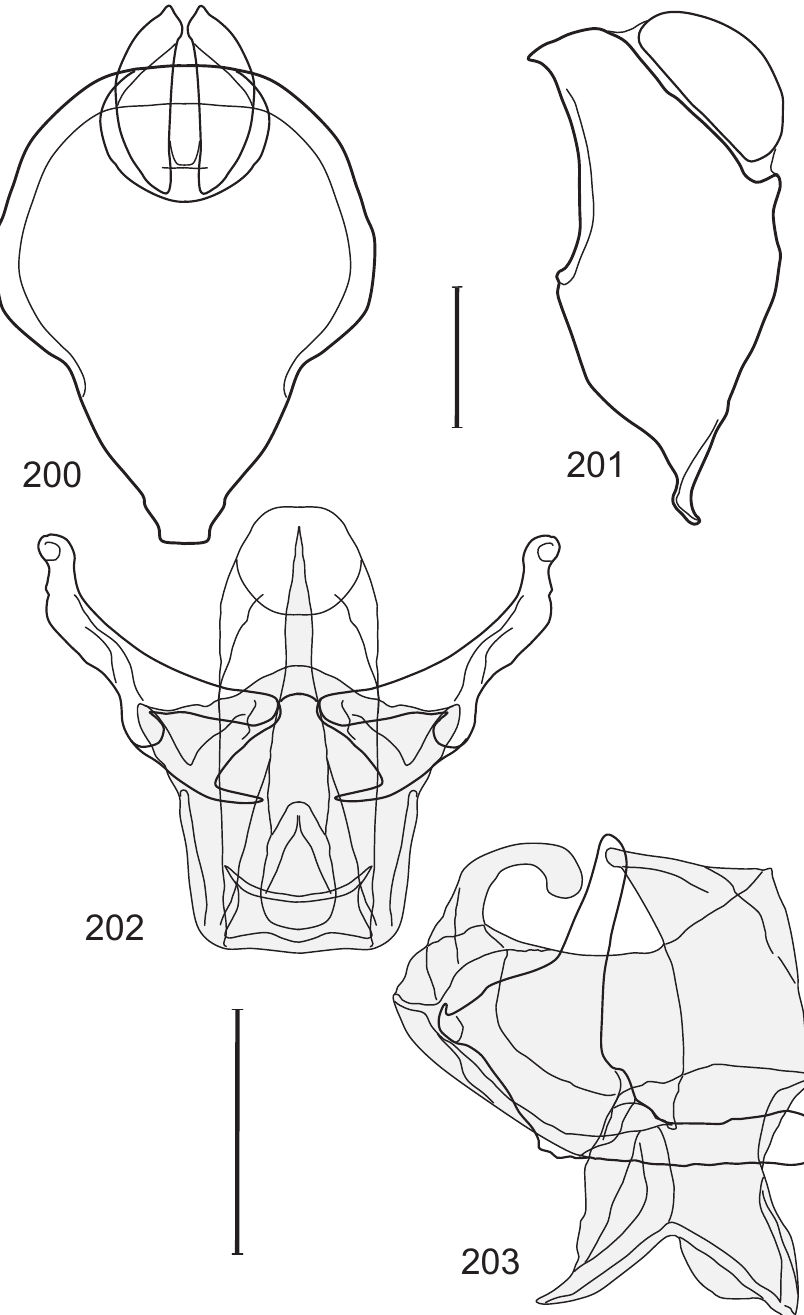
Figures 200–203. Discocerina ceraceps (Cresson) (Brazil, holotype) 200 outline of epandrium and cerci, posterior view 201 same, lateral view 202 internal structures of male terminalia (aedeagus [shaded], phal- lapodeme, gonite, hypandrium), ventral view 203 same, lateral view. Scale bar = 0.1